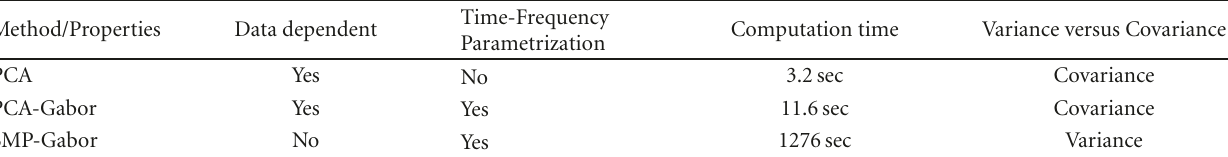
Table 3: A qualitative comparison of the three data reduction methods discussed in this paper.